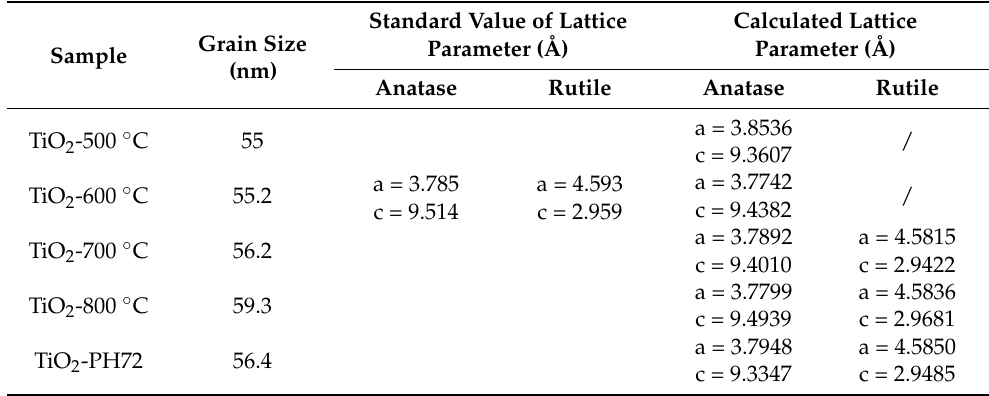
Table 1. Grain size and lattice constant of all